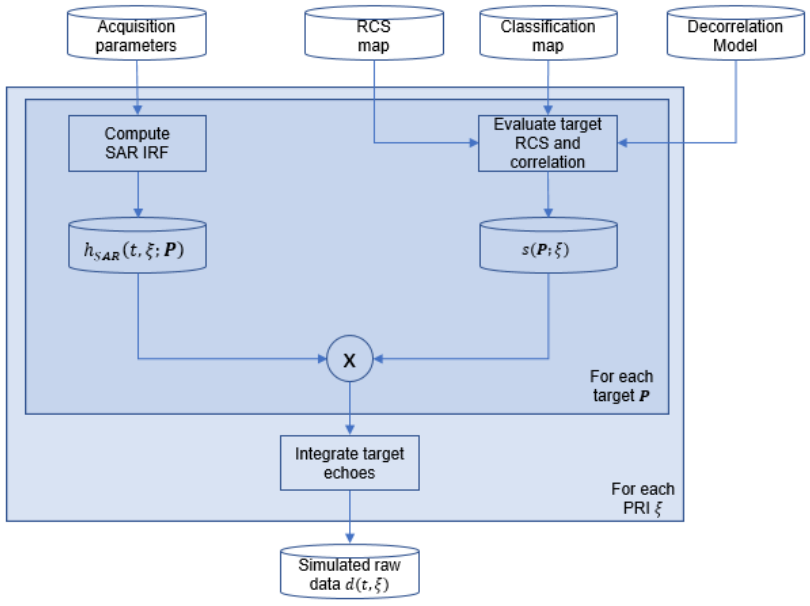
Figure 18. Flow chart of the scene decorrelation simulation approach.